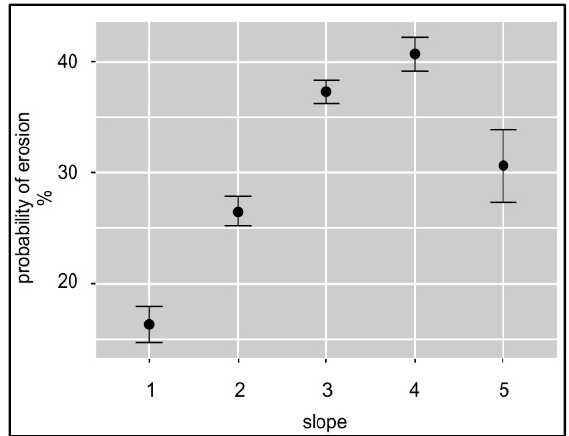
Figure 4. Category of slope: 1 (0–1°), 2 (1–3°), 3 (3–7°), 4 (7–12°), 5 (>12°).